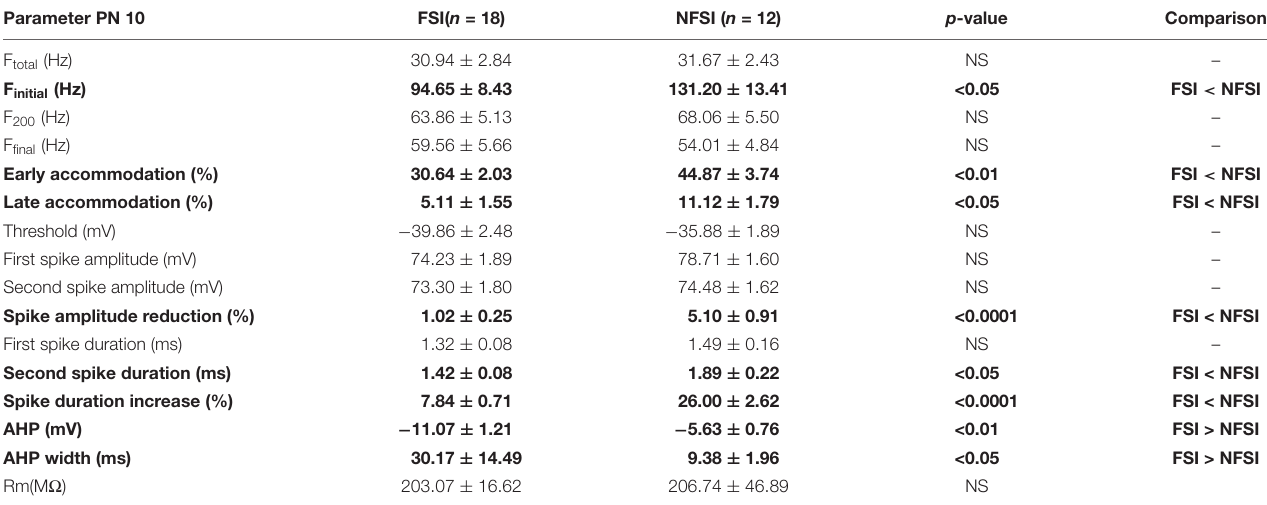
TABLE 1 | Electrophysiological properties of FSI and NFSI at PN10 in Nkx2.1 Cre :ChR2-YFP Lox / + mice. Parameter PN